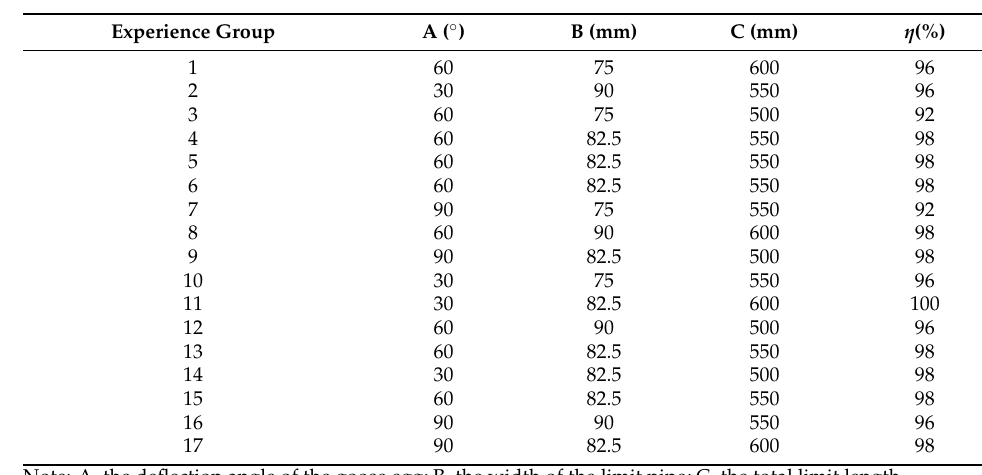
Table 1. Attitude adjustment results of limit devices with different sizes.